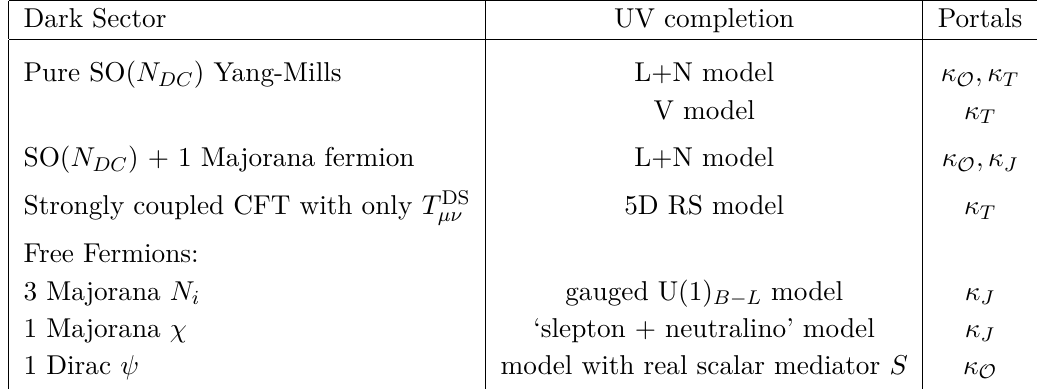
Figure 1 . Cartoon of the three possible situations characterizing the energy dark sector is probed, compared to the scales Λ